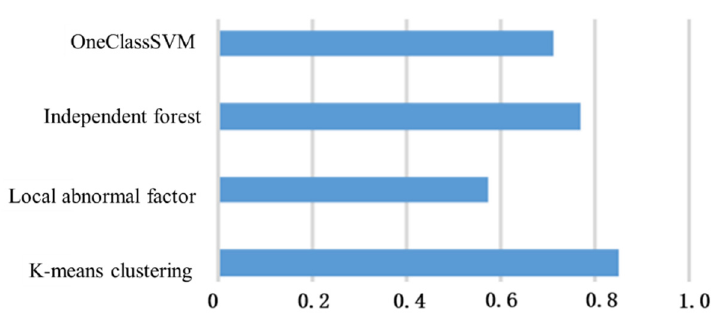
Figure 4. Silhouette coefficient.